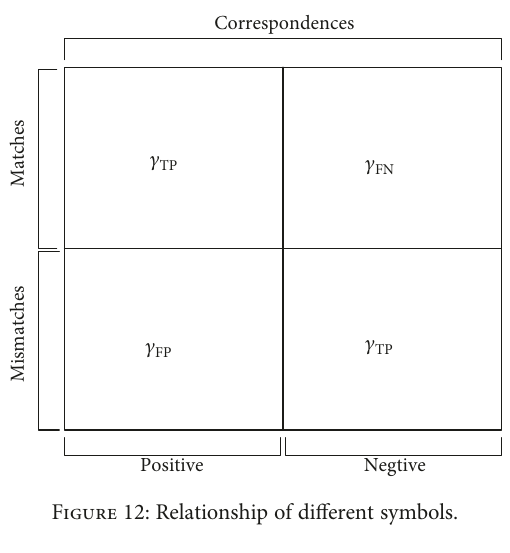
Figure 12: Relationship of di ff erent